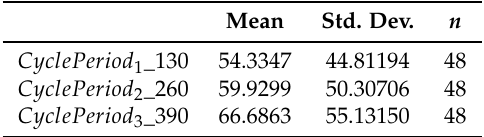
Table 6. Descriptive Statistics of Study Variables